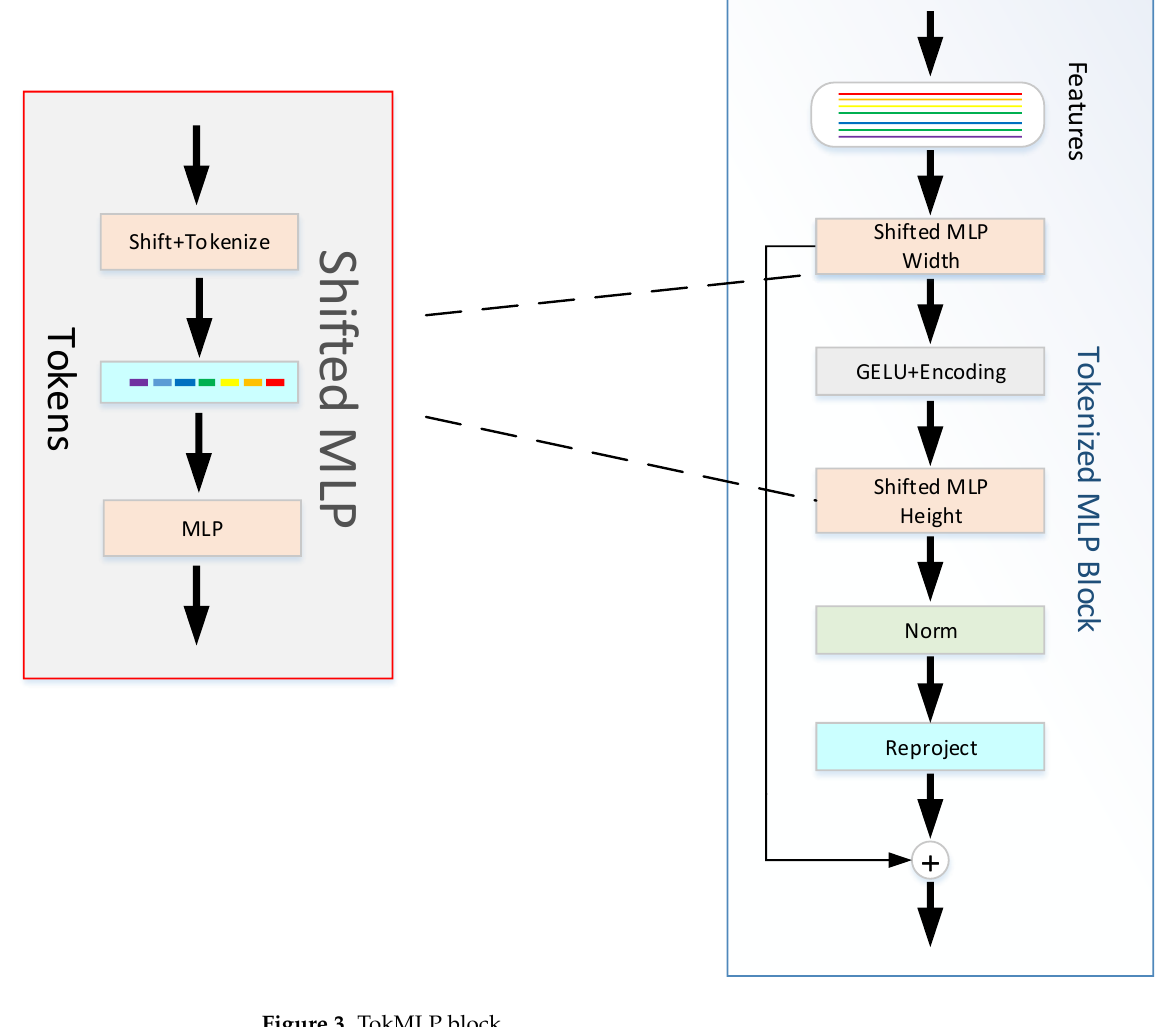
Figure 3. TokMLP block.